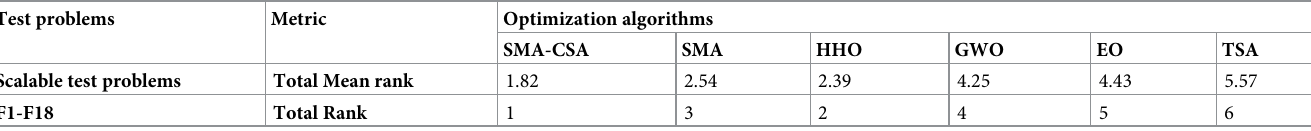
Table 10. Comparison results on Friedman’s ranking test with traditional algorithms with 60